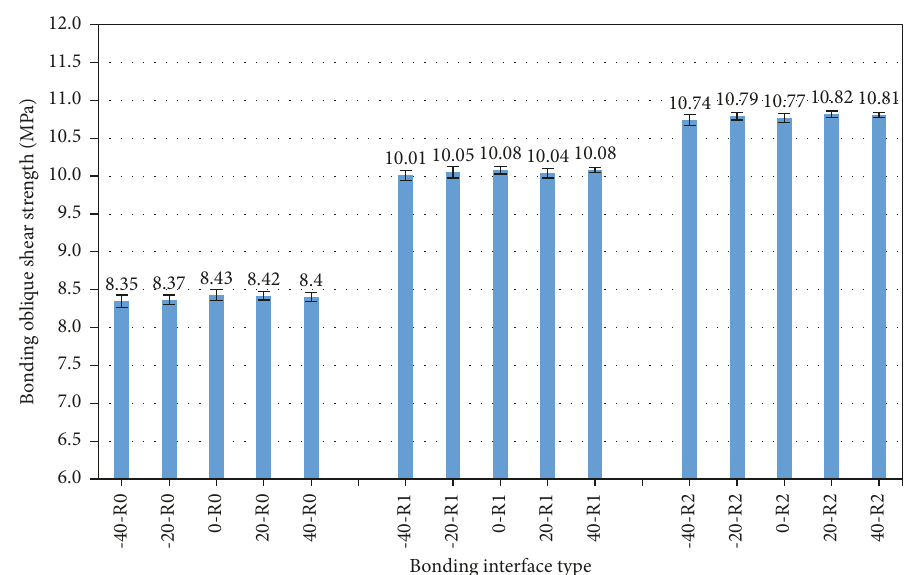
Figure 30: Bond oblique shear strength under different interfaces and different